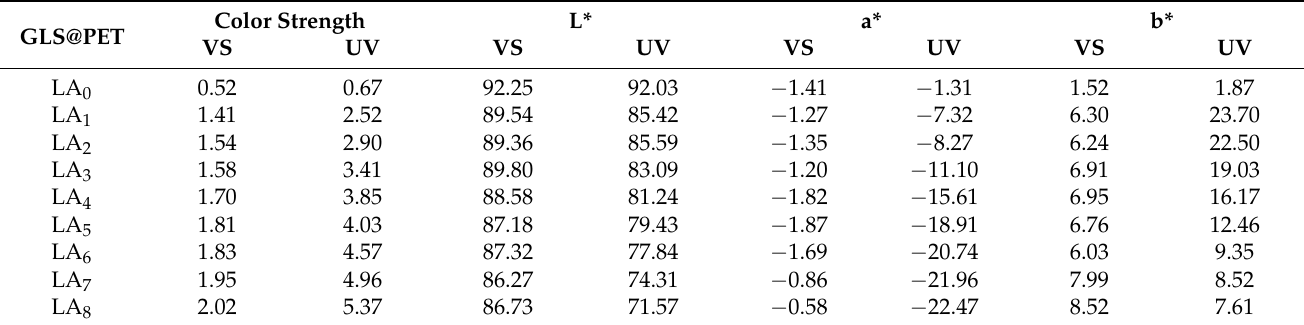
Table 3. Colorimetric screening of LANPs-free and LANPs-loaded GLS@PET below visible spectrum (VS), and UV illumination; L* represents lightness between black(0) and white(100), a* represents color ratio between red(+a*) and green( − a*), and b* represents color ratio between yellow(+b*) and blue( − b*).